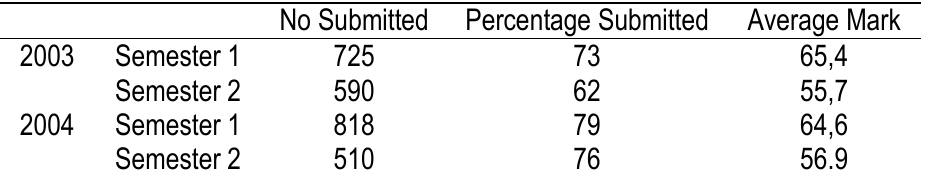
Table 1.1a indicates that in semester 1 of 2003, 60% of registered MNX202-J students submitted assignments for which the average mark was 62,8%. In semester 1 of 2004, 49% of registered MNX202-J students submitted assignments and the average mark obtained was 57,8 percent. Table 1.1b. Number of assignments submitted by MNF301-5 students and average mark of assignment